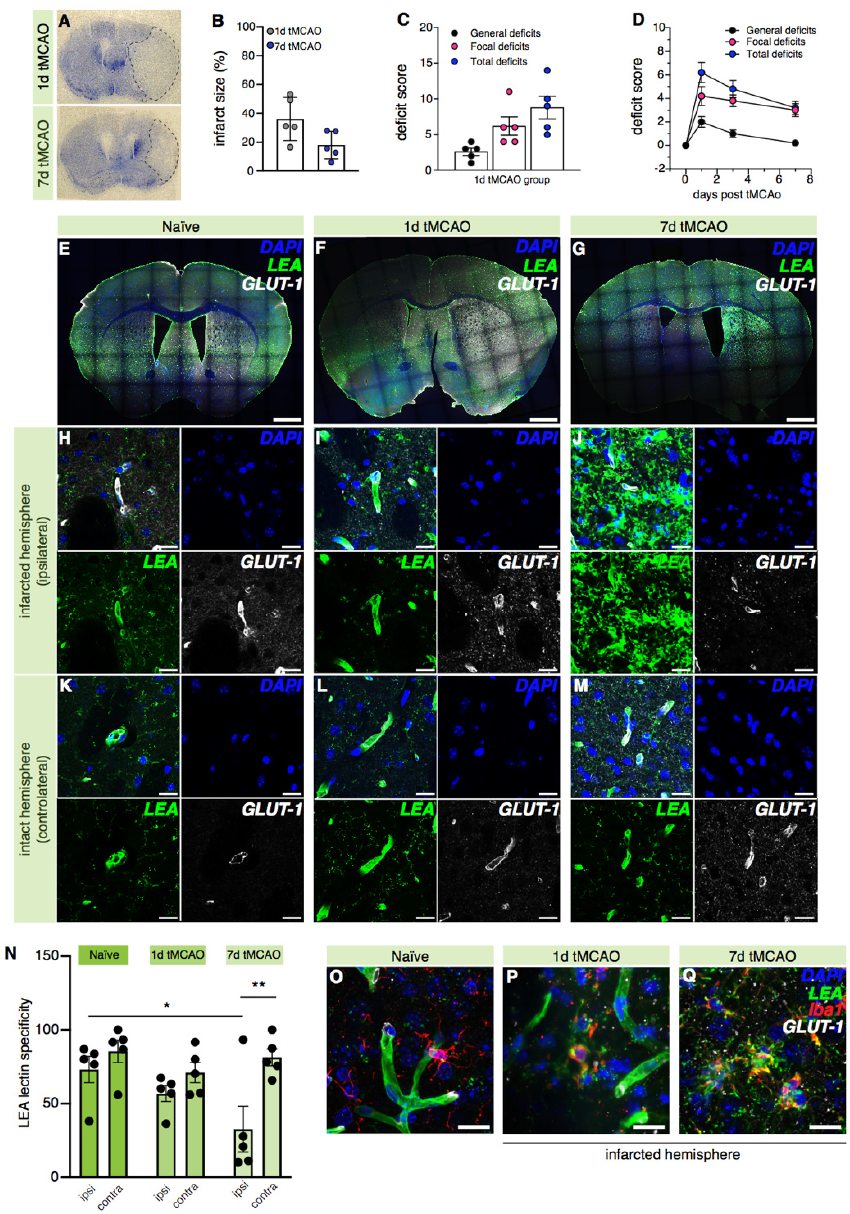
Figure 5. Analysis of the LEA lectin´s labeling of blood vessels in the ischemic core of a post-stroke brain. ( A ) Representative micrograph of the infarcted area (dashed line) in the brain sections of mice 1 and 7 days after transient occlusion of the medial cerebral artery labeled with Nissl staining. Note the infarcted region that appears white. ( B ) Quantification of the infarct size in mice 1 and 7 days post-tMCAo (unpaired t -test, p = 0.0522); n = 5 mice/group. ( C ) Neuroscore values in mice 1 day post-tMCAo; n = 5 mice. ( D ) Neuroscore in mice 7 days post-tMCAo; n = 5 mice. ( E – M ) Representa- tive confocal images of brain sections at 10× magnification ( E – G ; scale bars: 1 mm) and related blood vessels at 20× magnification ( H – M ; scale bars: 20 µm) of the naïve, 1d tMCAo, and 7d tMCAo mice labeled with the LEA lectin and the GLUT-1 antibody (counterstain: DAPI). ( N ) Quantification of the LEA lectin specificity (two-way ANOVA test, hemisphere effect, p = 0.0025; Tukey’s multiple comparisons test for the infarcted hemisphere: naïve vs. 1d tMCAo, p = 0.4239; naïve vs. 7d tMCAo, p = 0.0112; 1d tMCAo vs. 7d tMCAo, p = 0.1619; for the intact hemisphere: naïve vs. 1d tMCAo, p = 0.5030; naïve vs. 7d tMCAo, p = 0.9451; 1d tMCAo vs. 7d tMCAo, p = 0.6983; Sidak’s multiple com- parisons test, infarcted vs. intact hemispheres: naïve, p = 0.6566; 1d tMCAo, p = 0.5601; 7d tMCAo, p = 0.0034); n = 5 mice/group. * = p < 0.05; ** = p < 0.01. ( O – Q ) Representative confocal images of the LEA lectin and Iba1 signal overlapping in the infarcted hemisphere of the 1d tMCAo and 7d tMCAo mice compared to the naïve mice. Scale bars: 20 µm.